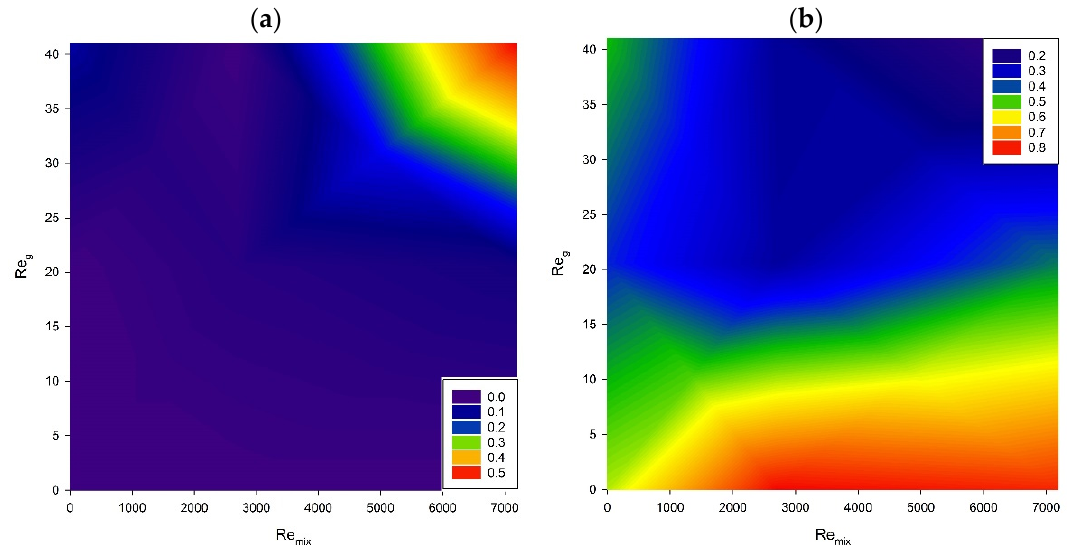
Figure 8. Impact of process conditions on the yield factor Y PX for ( a ) pyocyanin and ( b ) rhamno- lipids.